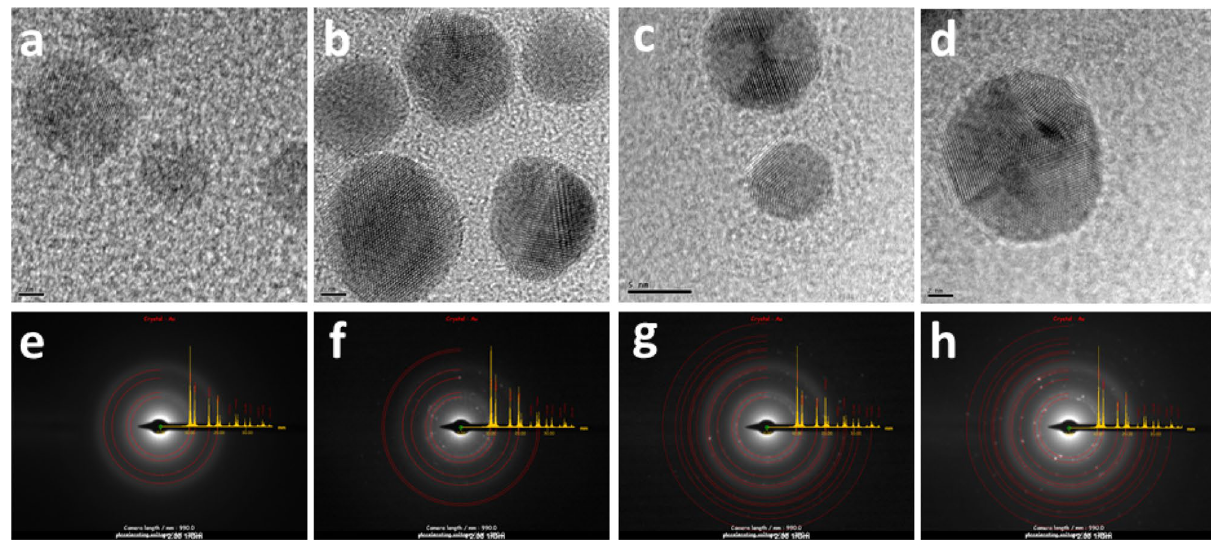
Figure 5. HR-TEM images and SAED pattern of biosynthesized gold nanoparticles: ( a , e ) AuNP extract ; ( b , f ) AuNP ethyl acetate ; ( c , g ) AuNP dichloromethane ; ( d , h ) AuNP hexane.